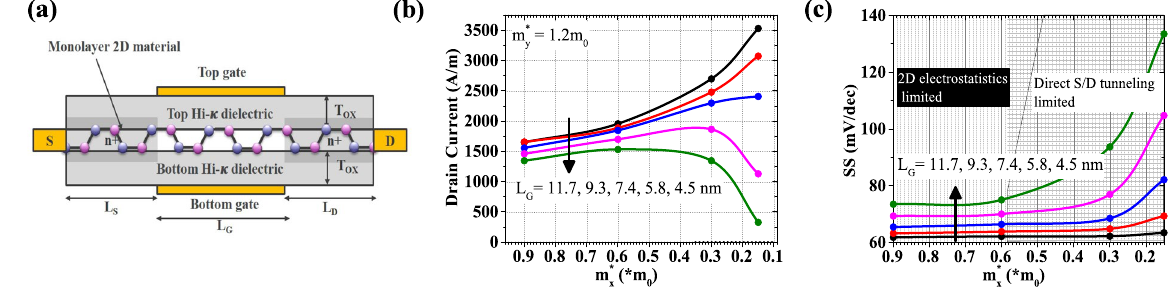
Figure 2. Device Simulations, ( a ) Double-gate monolayer 2D material based FET with L S = L D = 15 nm, and n + doping of source/drain = 4 × 10 13 cm − 2 , and for a fixed transverse effective mass ( ⁎ m direction effective mass ( ⁎ m ) and gate length ( L G ) on, ( b ) ON current including effect of scattering and contact x resistances, and, ( c ) Extracted subthreshold slope near OFF state.